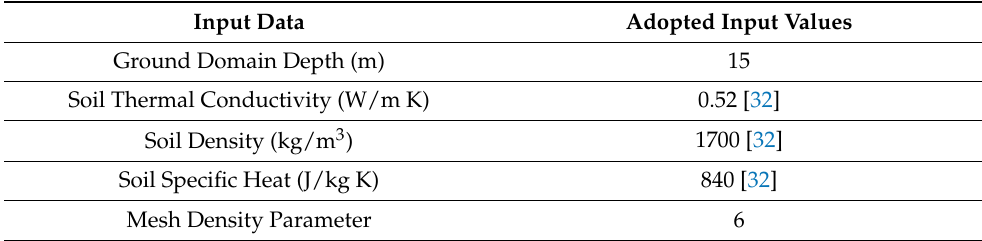
Table 3. Input data considered in GDomain